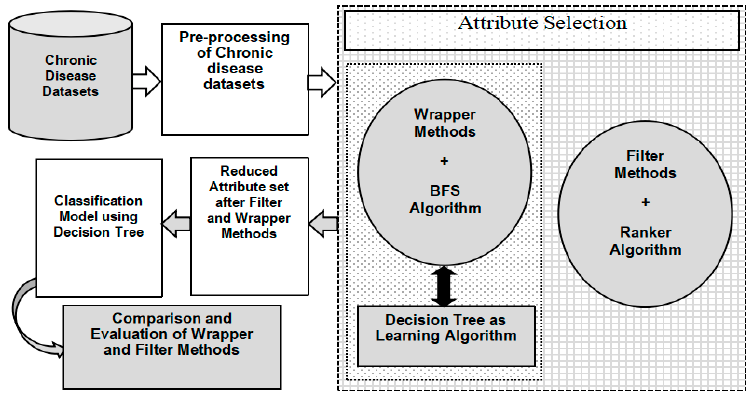
Figure 5. The Work-flow Model of Wrapper-Filter Methodology.